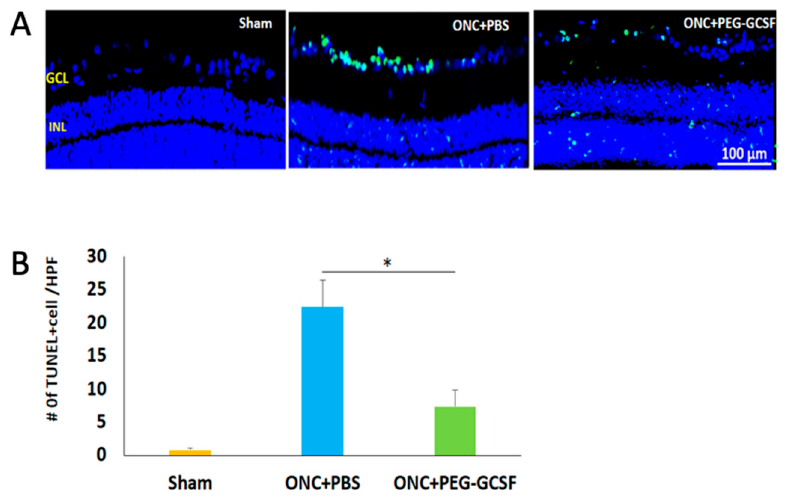
Figure 5. Morphometry and survival of retinal ganglion cells (RGCs) in the sham-operated rats and the optic nerve crushed (ONC) rats treated with intravitreal injection (IVI) of phosphate-buffered saline (PBS), or IVI of pegylated granulocyte colony-stimulating factor (PEG-G-CSF) two weeks after operation. ( A ) Representative images of flat-mounted central retinas and the RGCs labeled by Fluoro-Gold at two weeks post-operation in each group. ( B ) RGC density in the central retina in each group. The number of RGCs in the PEG-G-CSF-treated group was 1.7-fold higher than that in the PBS-treated group. Data are expressed as mean ± standard deviation (SD) for each group (n = 6). (*: p < 0.05).